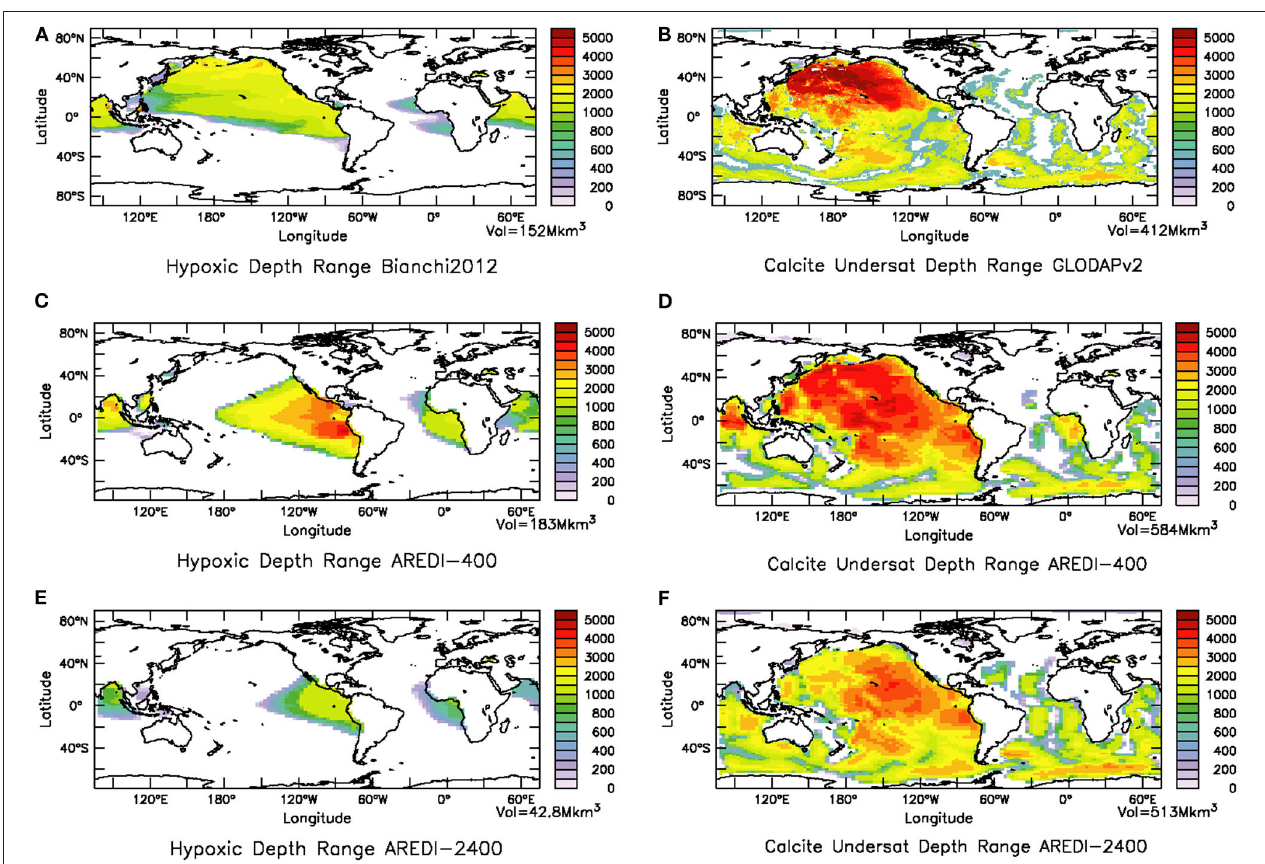
FIGURE 10 | Influence of mixing coefficient on mean-state hypoxia and calcite undersaturation. (A) Observations, taken from Bianchi et al. (2012), of depth of water in m column occupied by hypoxic waters and (B) observations from GLODAP (Lauvset et al., 2016) of the depth of the water column in m over which calcite undersaturation is found. (C) Hypoxic depth range for low-mixing model AREDI-400, (D) depth range of calcite undersaturation for low-mixing model AREDI-400, (E) Hypoxic depth range for high-mixing model AREDI-2400, and (F) depth range of calcite undersaturation for high-mixing model